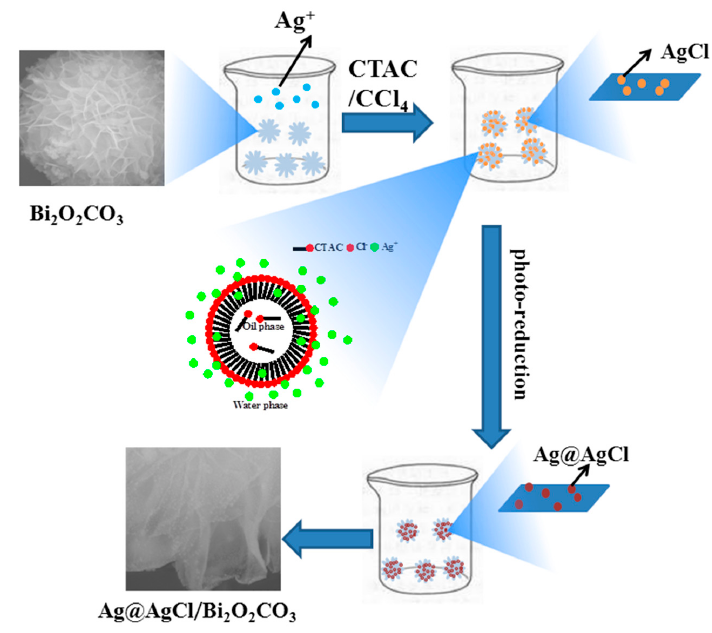
Figure 1. Schematic illustration for the preparation of Ag@AgCl/Bi 2 O 2 CO 3 .